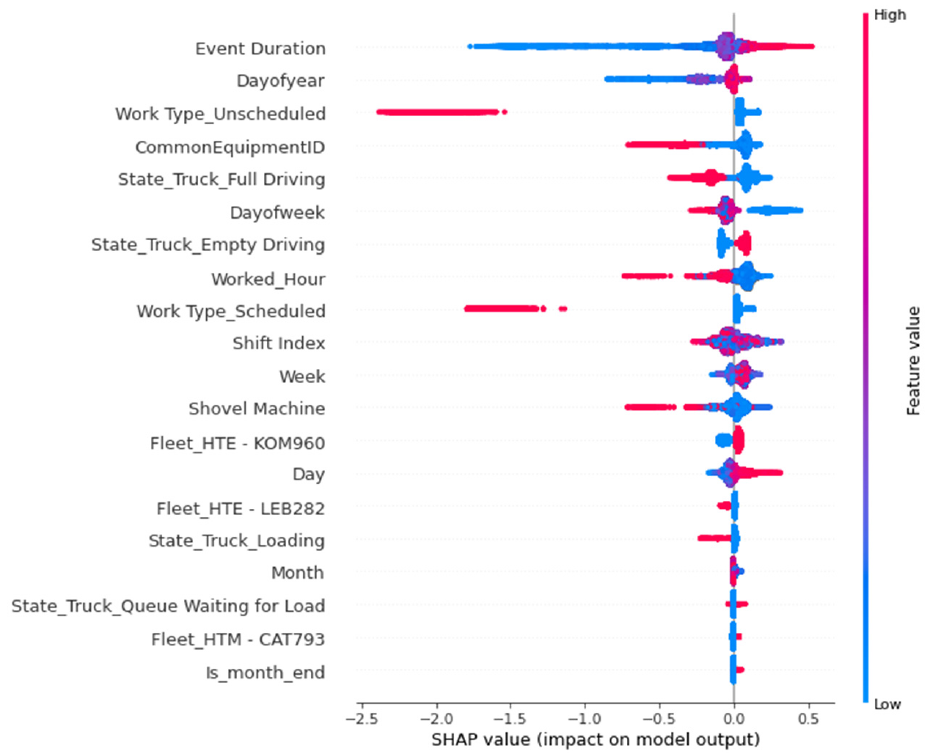
Figure 14. SHAP value of the fifth model.